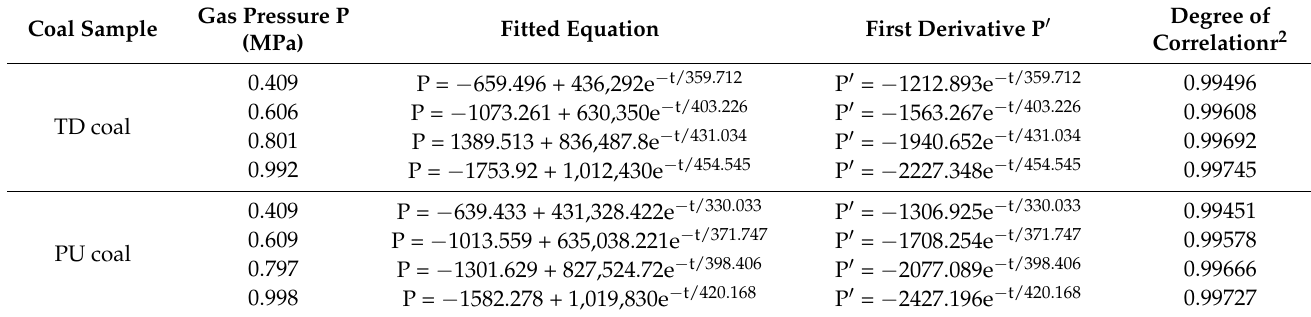
Figure 3. Change curve of gas pressure with time during gas initial desorption of coal particles. Table 2. Fitting relationship of gas pressure vs. time during the initial desorption.